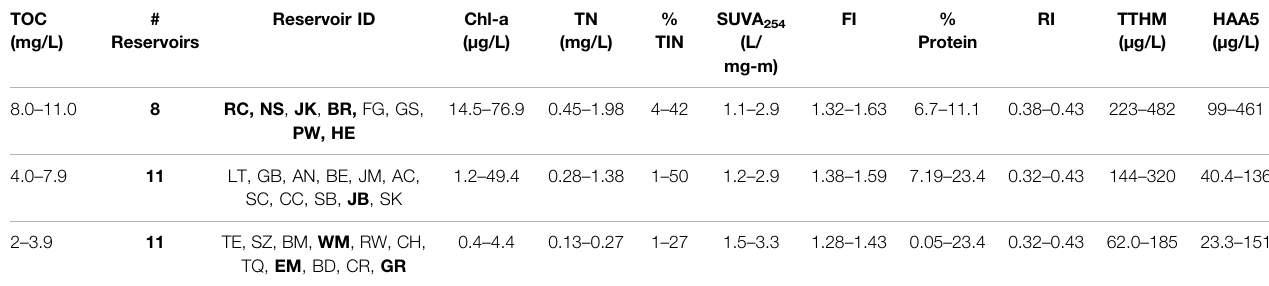
TABLE 3 | Reservoir Water Quality Data summary organized by TOC concentration. TOC